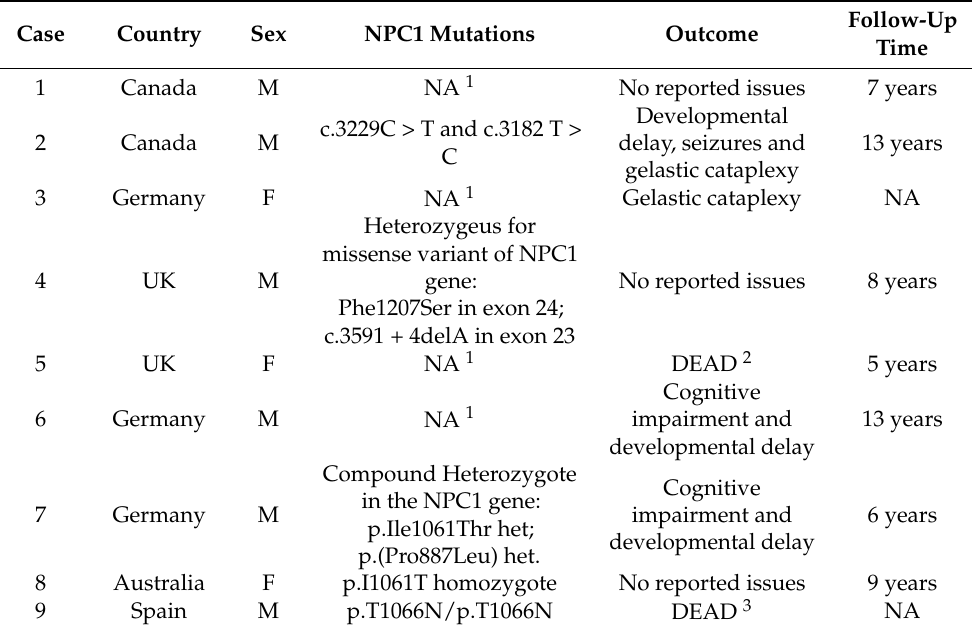
Table 2. Mutations detected in 9 patients diagnosed with Niemann Pick type C and the clinical outcome after liver